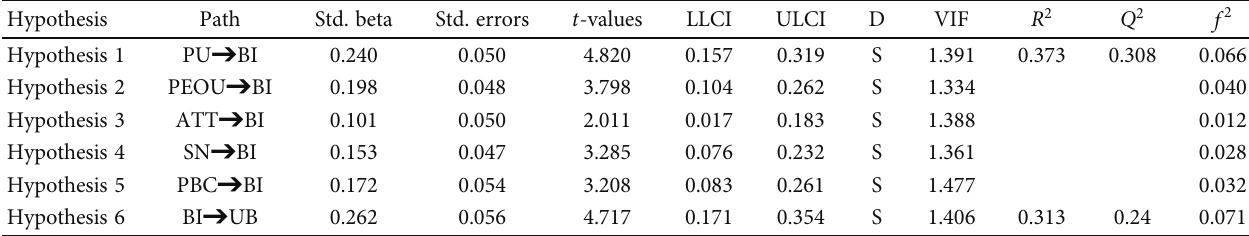
Table 4: Hypothesis test